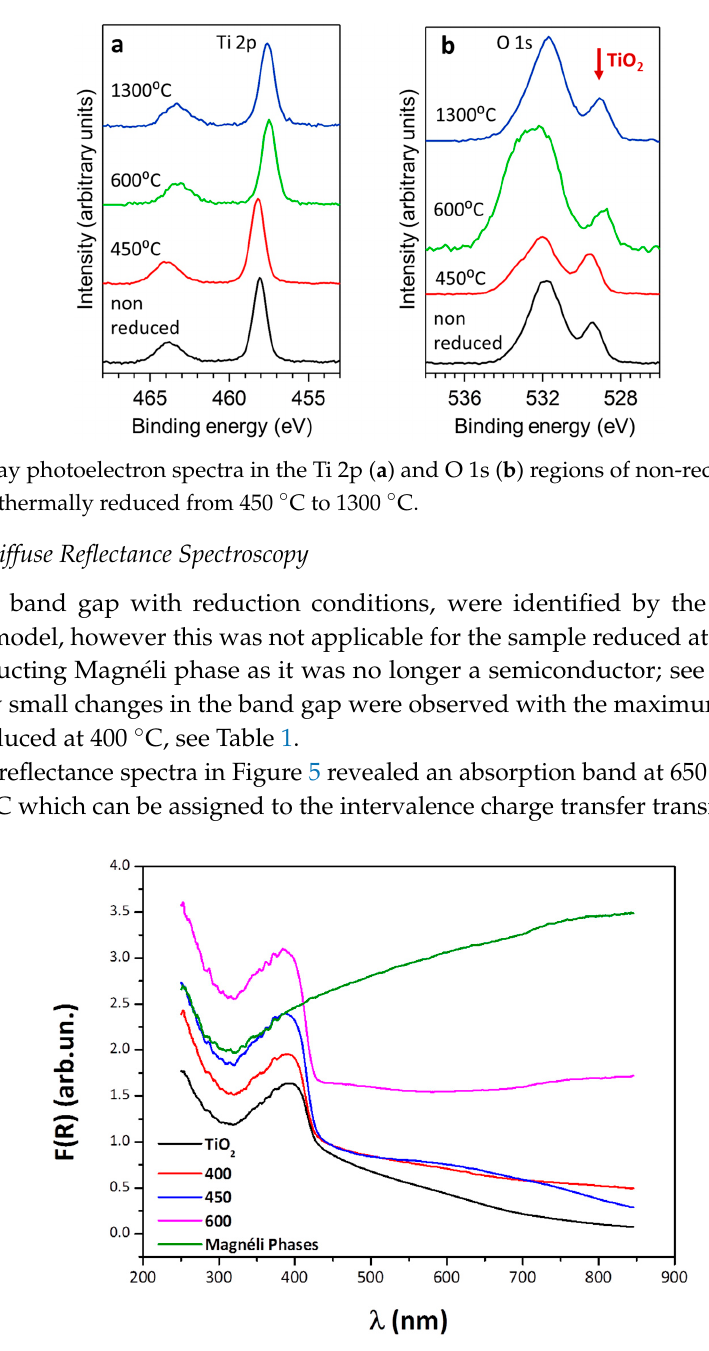
Figure 5. Diffuse reflectance spectra for rutile and reduced samples. Table 1. Optical band gap of TiO n